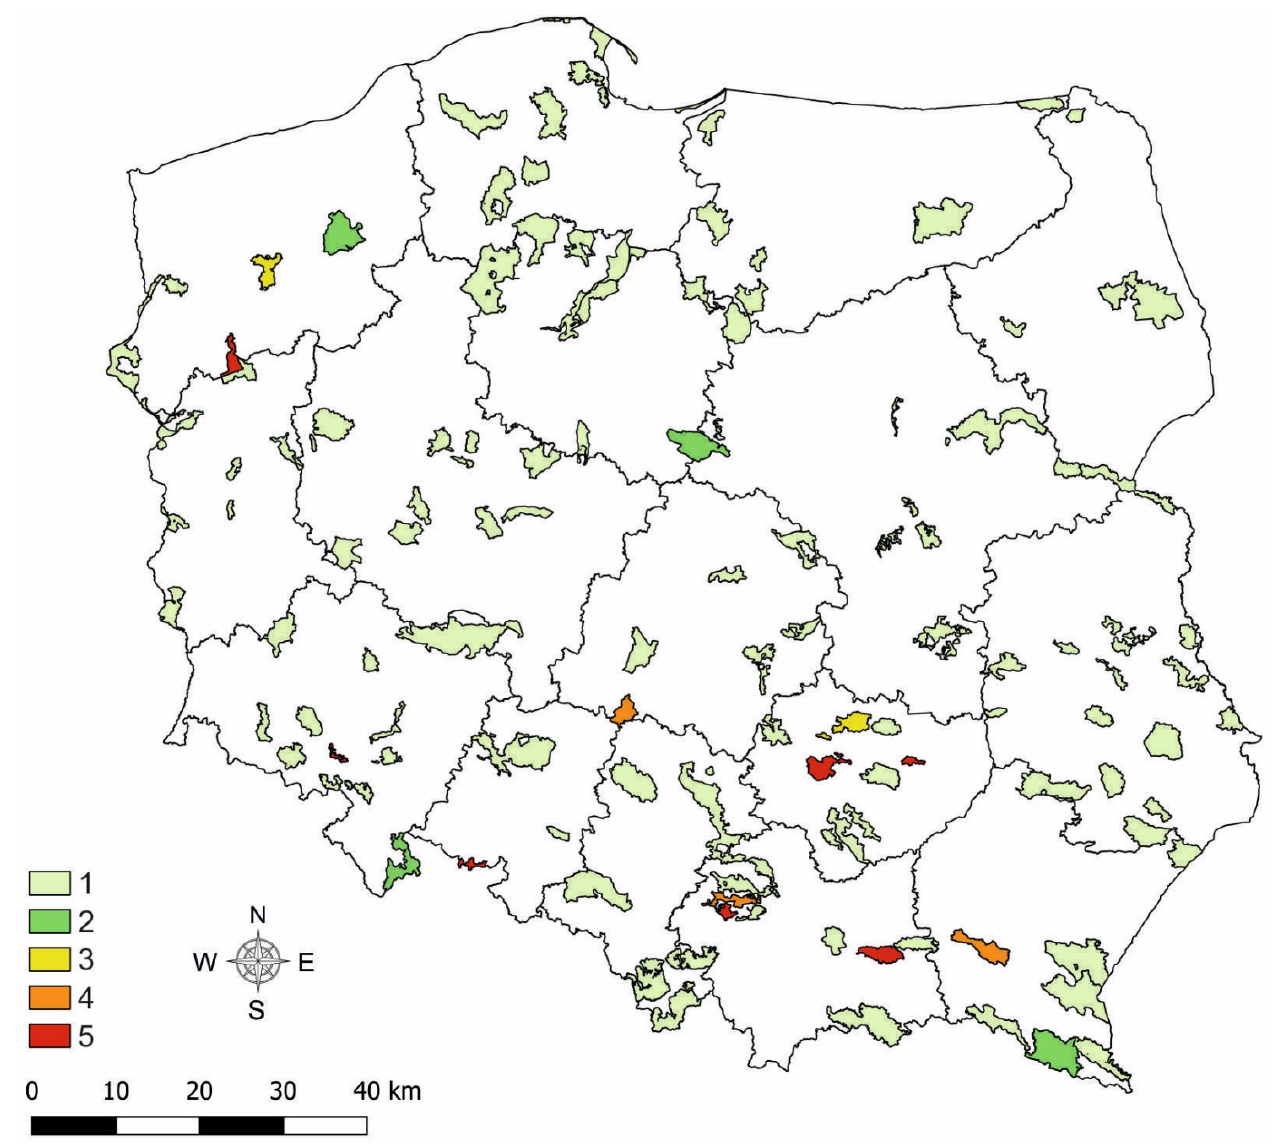
Figure 3. Density of nature reserves within landscape parks (per 100 km 2 ). 1: <0.06, 2: 0.06–0.10, 3: 0.11–0.15, 4: 0.16–0.20, 5: >0.20.